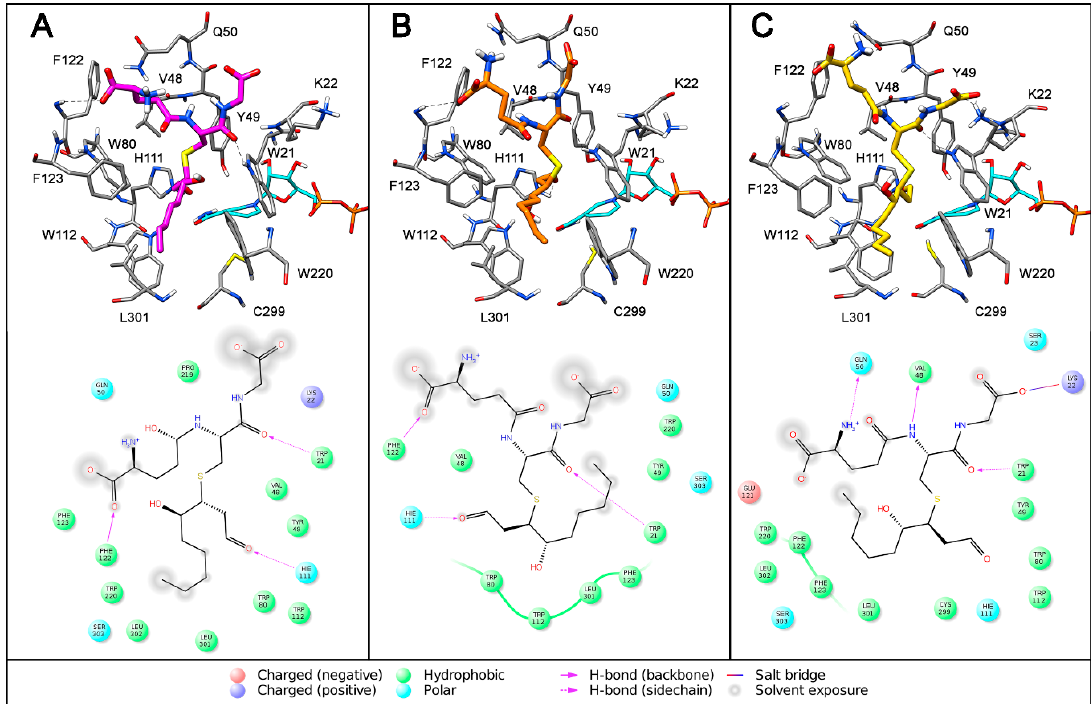
Figure 6. Interaction of h AR1B1 with different GSHNE diastereoisomers . The minimized average structures of 3 R, 4 R -GSHNE ( A ), 3 R ,4 S -GSHNE ( B ) and 3 S ,4 S -GSHNE ( C ) docked into the h AKR1B1 active site are reported. All interactions between the GSHNE and enzyme residues are shown.